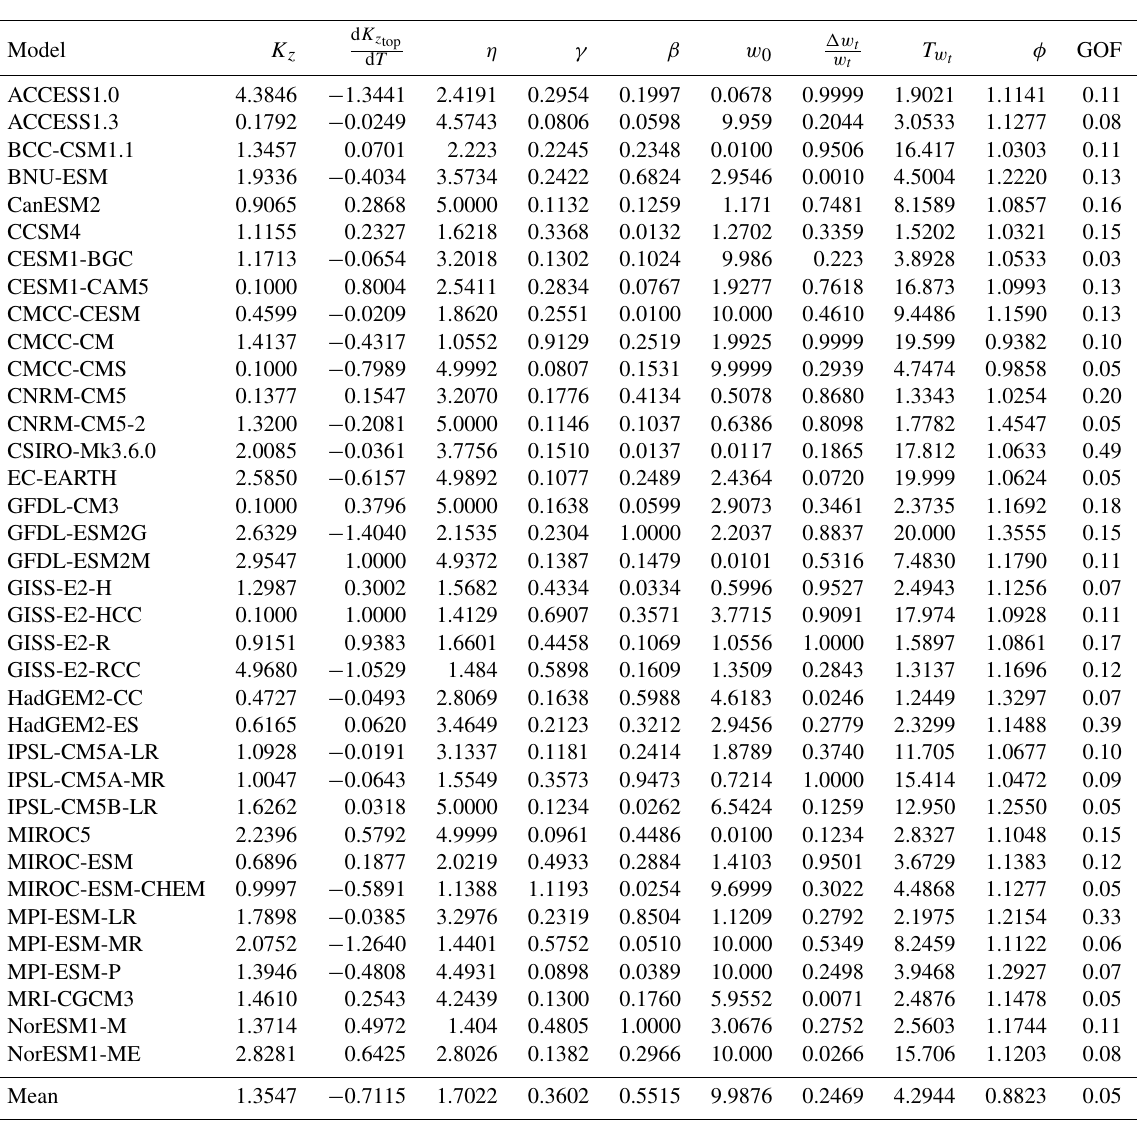
Table 1. MAGICC ocean model calibration results with optimal sets of ocean and thermal expansion calibration parameters for the available CMIP5 models. Calibration parameters are introduced in Sect. 2.6. Goodness-of-fit (GOF) results are given as weighted residual sum of squares (RSS) divided by the number of calibrated model years (weight potential ocean temperature [K]: 10; weight thermal expansion [mm]: 0.001). The optimal set for the mean response of the calibration data is given at the bottom of the